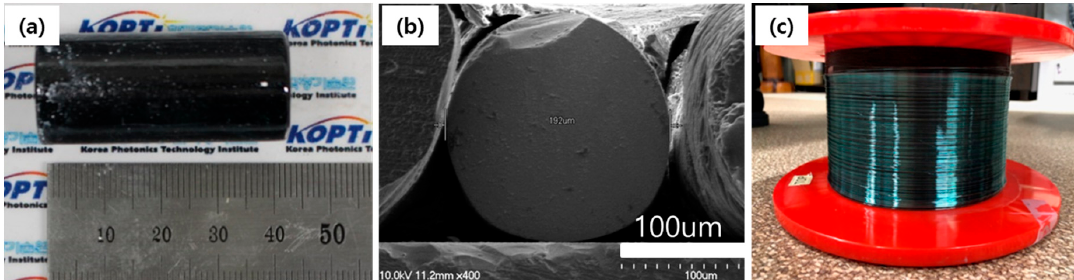
Figure 8. ( a ) Glass ingot; ( b ) microscope image of glass fiber with 180 μ m diameter; and ( c ) glass